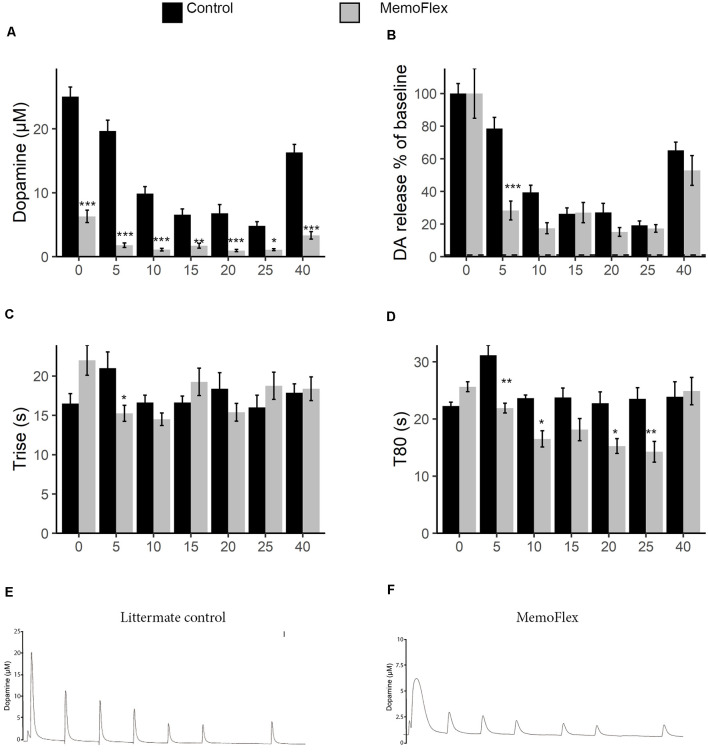
Potassium chloride (KCl)-induced release and clearance of extracellular dopamine (DA) in the dorsal striatum of MemoFlex and control mice. (A) Quantification of DA amplitude in response to six repeated KCl stimuli and, after a 15-min pause, of partial recovery of release amplitude in response to a seventh stimulation in control (black) and MemoFlex (gray) mice. (B) The same data as in a but normalized to baseline release per genotype. (C,D) Trise and T80 DA release parameters in control and MemoFlex mice. Mean values obtained for each stimulation (1–6) within each group. *p < 0.05, **p < 0.01, as determined using estimated marginal means (emmeans) with multivariate T (MVT) adjustment, expressed as mean ± SEM. MemoFlex: n = 8, three females, five males; controls: n = 8, six females, two males. (E,F) Example curves of DA release in control (E) and MemoFlex (F) mice. ***p < 0.001.